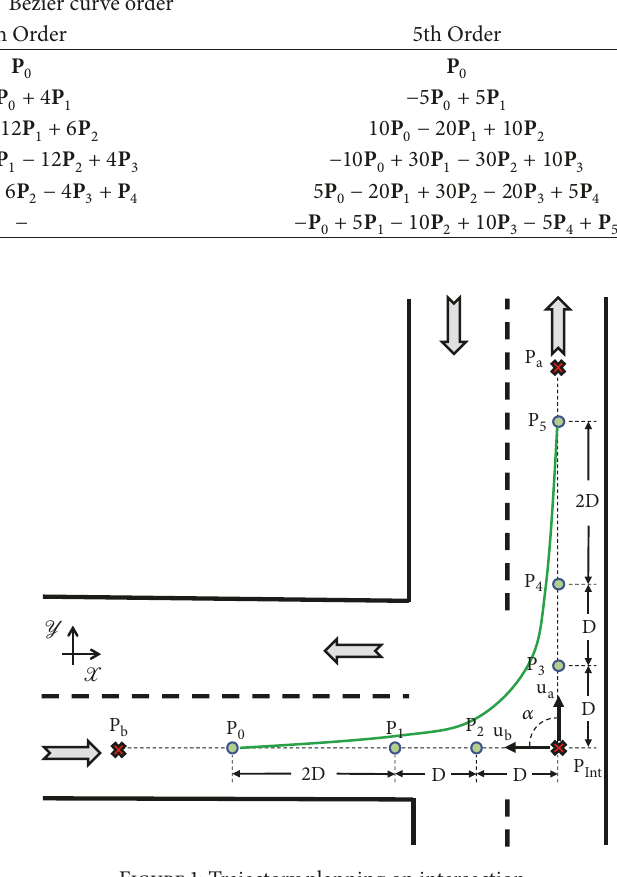
Figure 1: Trajectory planning on